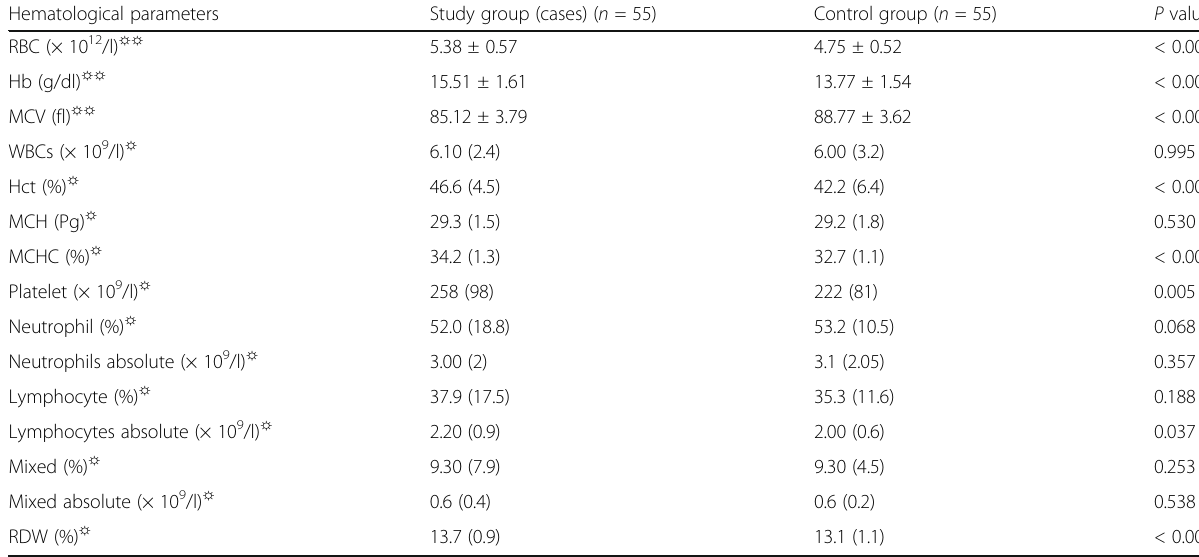
Table 3 Comparison of hematological parameters of study participants Hematological parameters Study group (cases) ( n = 55)